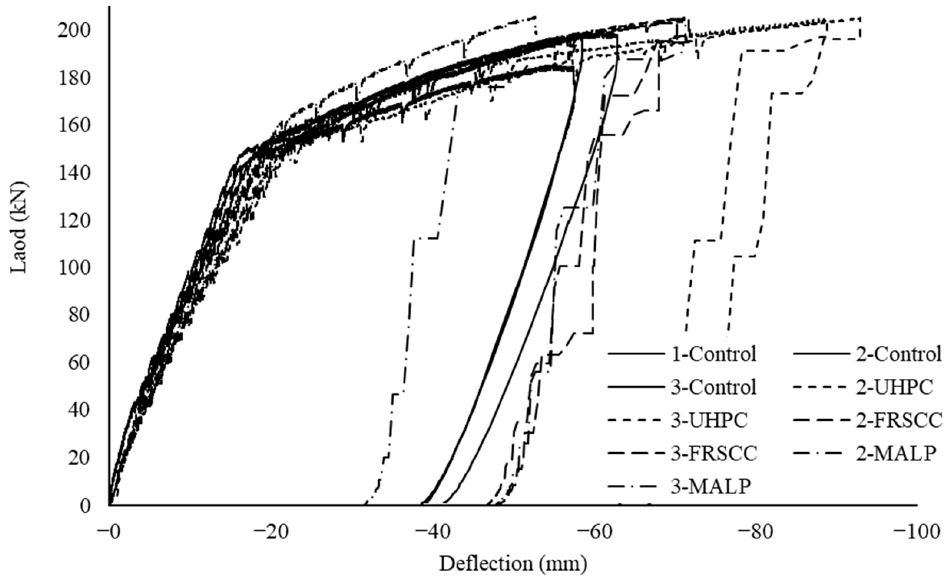
Figure 19. Load vs. deflection plot for all connected girder specimens.